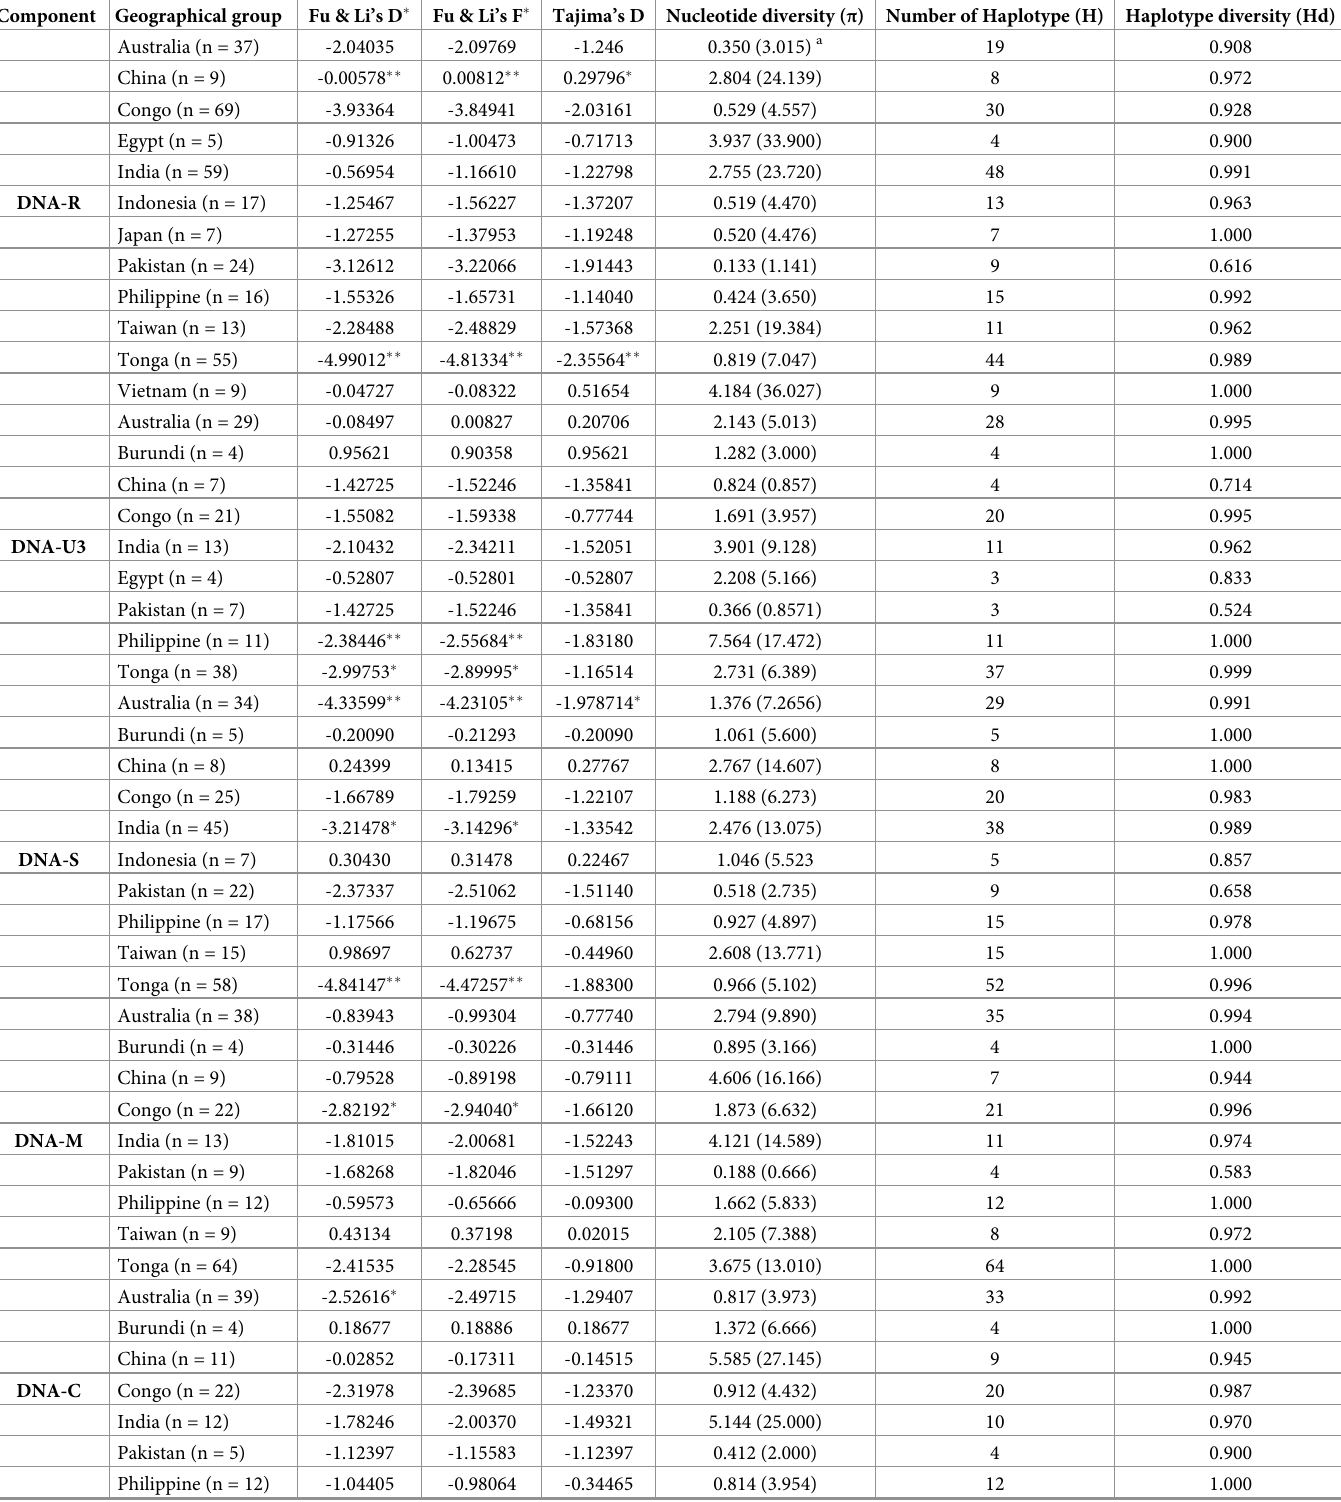
Table 6. Neutrality test, haplotype and nucleotide diversity of each BBTV population. Component Geographical